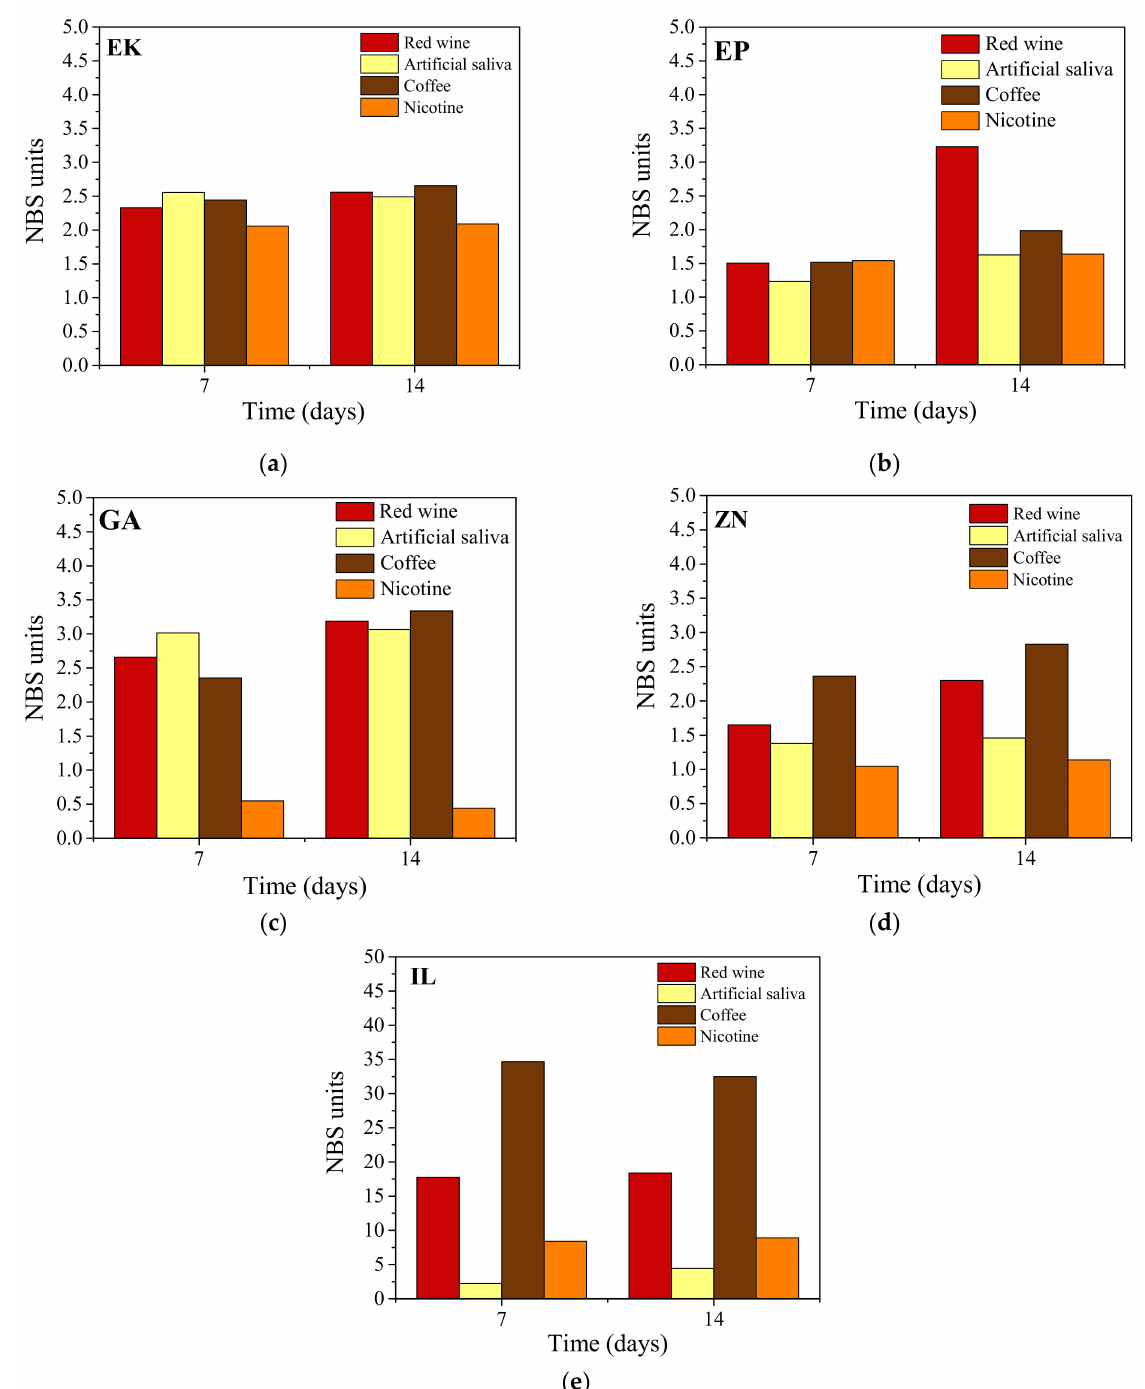
Figure 6. Colorimetric measurements of the considered aligners after 7 and 14 days of immersion into different staining solutions: ( a ) Erkodur (EK), ( b ) Essix Plastic (EP), ( c ) Ghost Aligner (GA), ( d ) Zendura (ZN) and ( e ) Invisalign